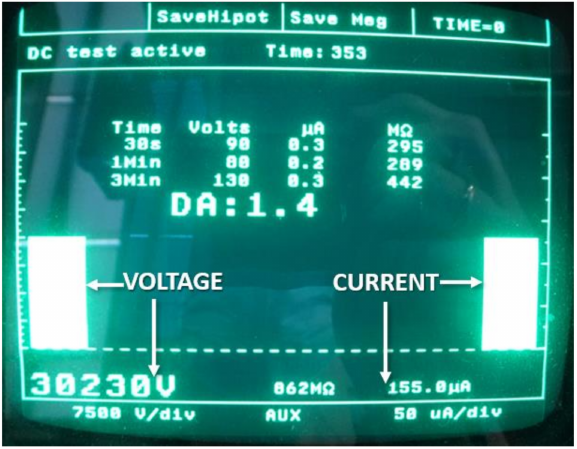
Figure 6. Results of a test.